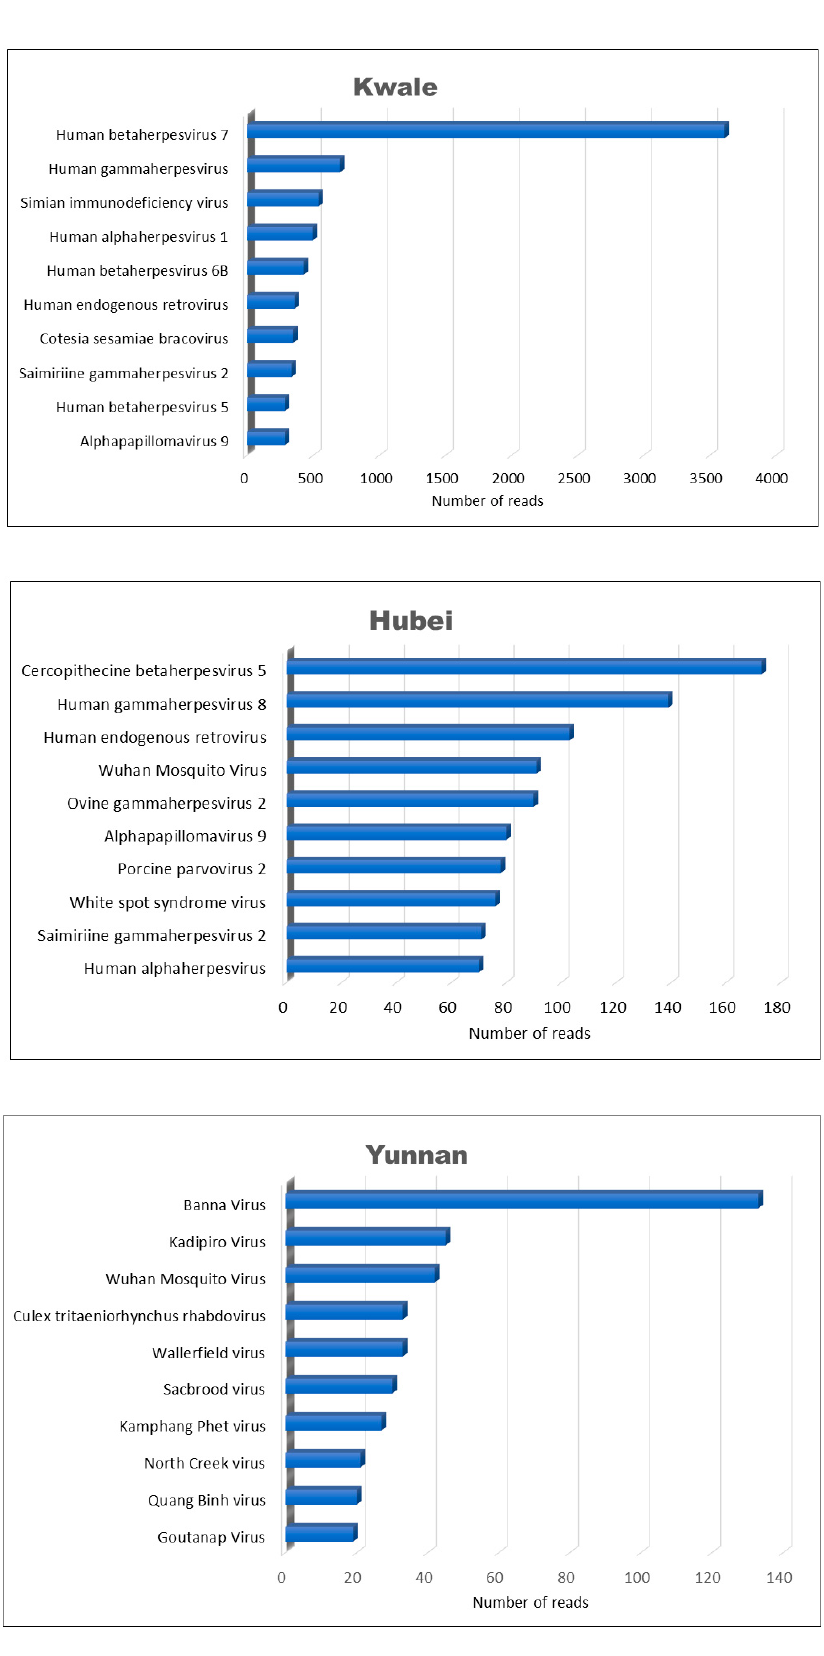
Figure 4. Abundance of the 10 most common virus species in Culex mosquito viromes in Kwale, Hubei, and Yunnan.